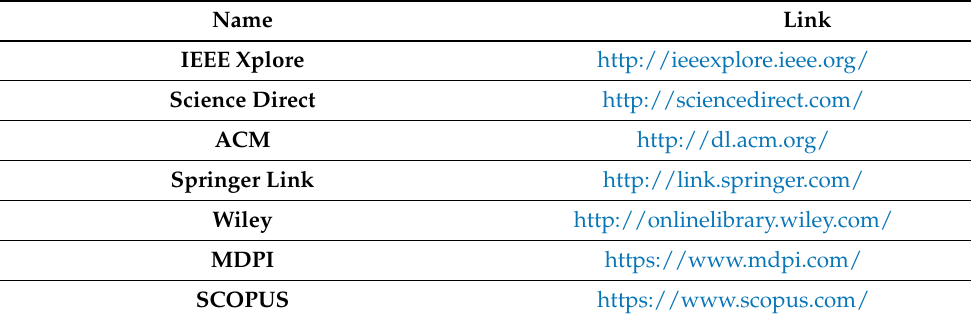
Table 1. Data sources.